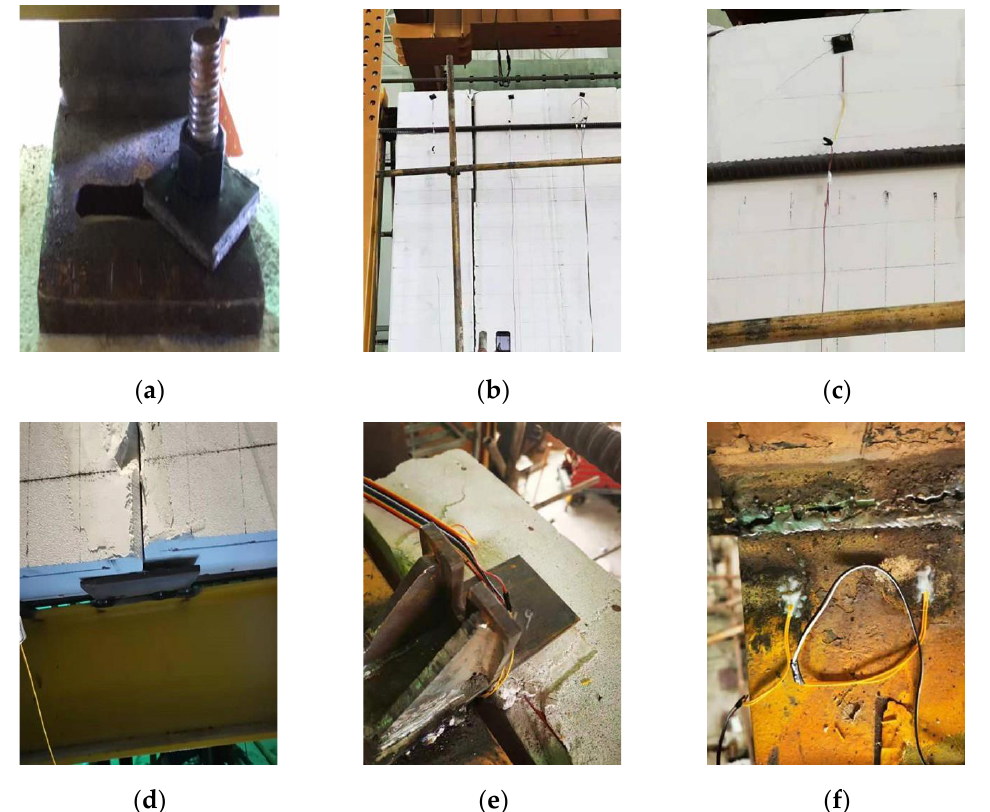
Figure 7. Phenomena during the test of JD-1. ( a ) Relative Sliding within bolt holes; ( b ) separating between the panels; ( c ) cracks at the bolt hole; ( d ) dislocation of ALC panels; ( e ) crushing of ALC panel near the upper connector; ( f ) weld fracture.